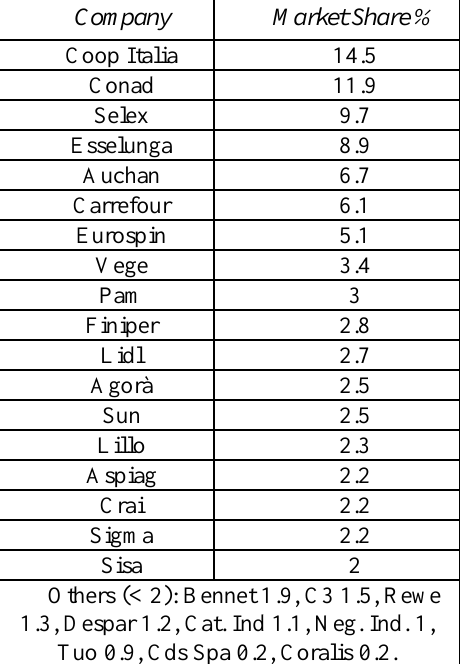
Table 2: The Main Large-Scale Retailers in the Italian Market. Market share in